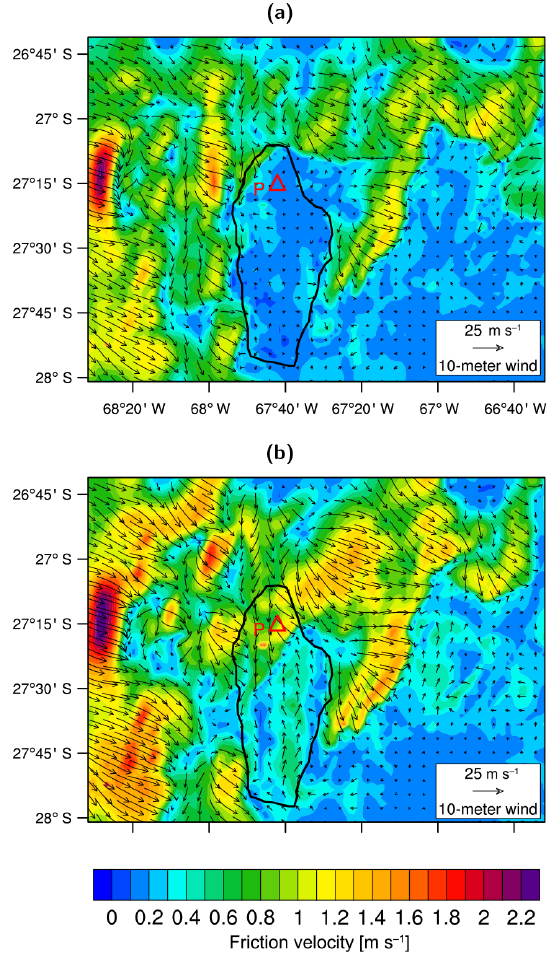
Figure 8. Friction velocity contours and wind vectors at 10m above the surface simulated by WRF model for the 2km innermost do- main at 15:00UTC on 12 June (a) and 15:00UTC on 13 June (b) . The Fiambalá Basin is defined by the outlined region (black line). We identify the geographic location P for future